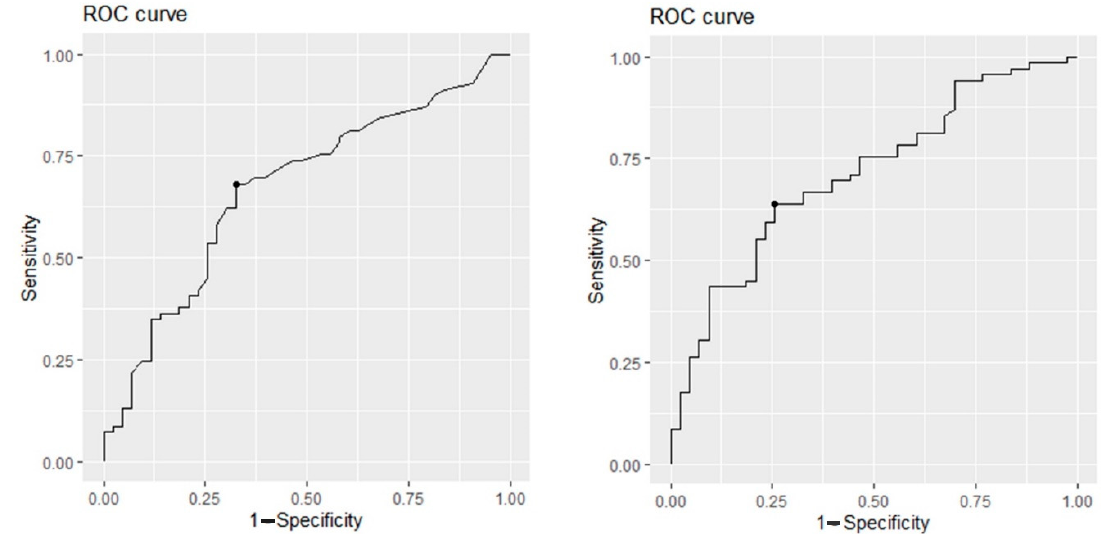
Figure 1. Visual assessment of 18 F-DOPA uptake in the basal ganglia (upper row) and in the pineal body (lower row) in patients with nigrostriatal dysfunction (NSD) ( A , B ) and in patients with non- NSD conditions ( C , D ). In NSD patients, notice the asymmetric decreased uptake pa tt ern in the basal ganglia (white arrows) with concurrent increased pineal body uptake compared to the background (pink arrows). Non-NSD patients demonstrated normal 18 F-DOPA uptake pa tt ern in the basal ganglia with virtually absent uptake in the pineal body.